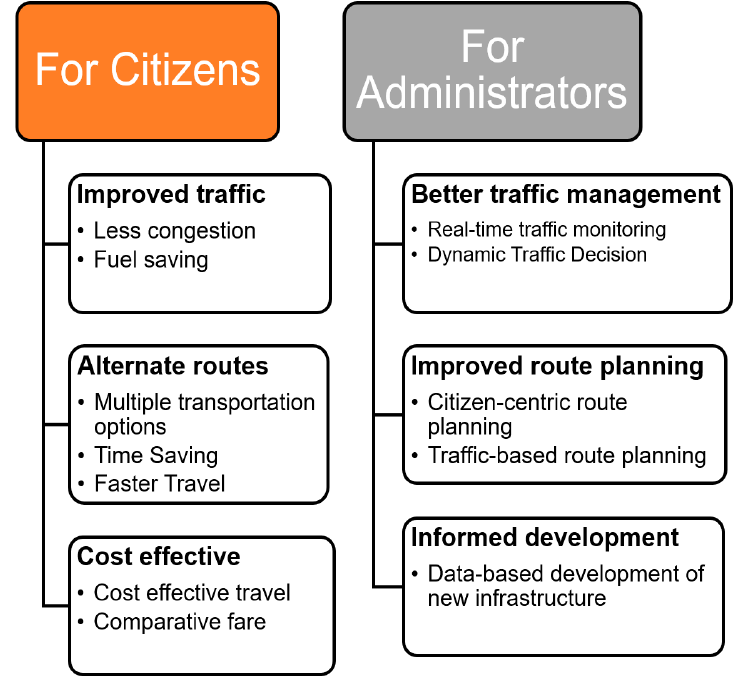
Figure 1. Need and importance of smart mobility.